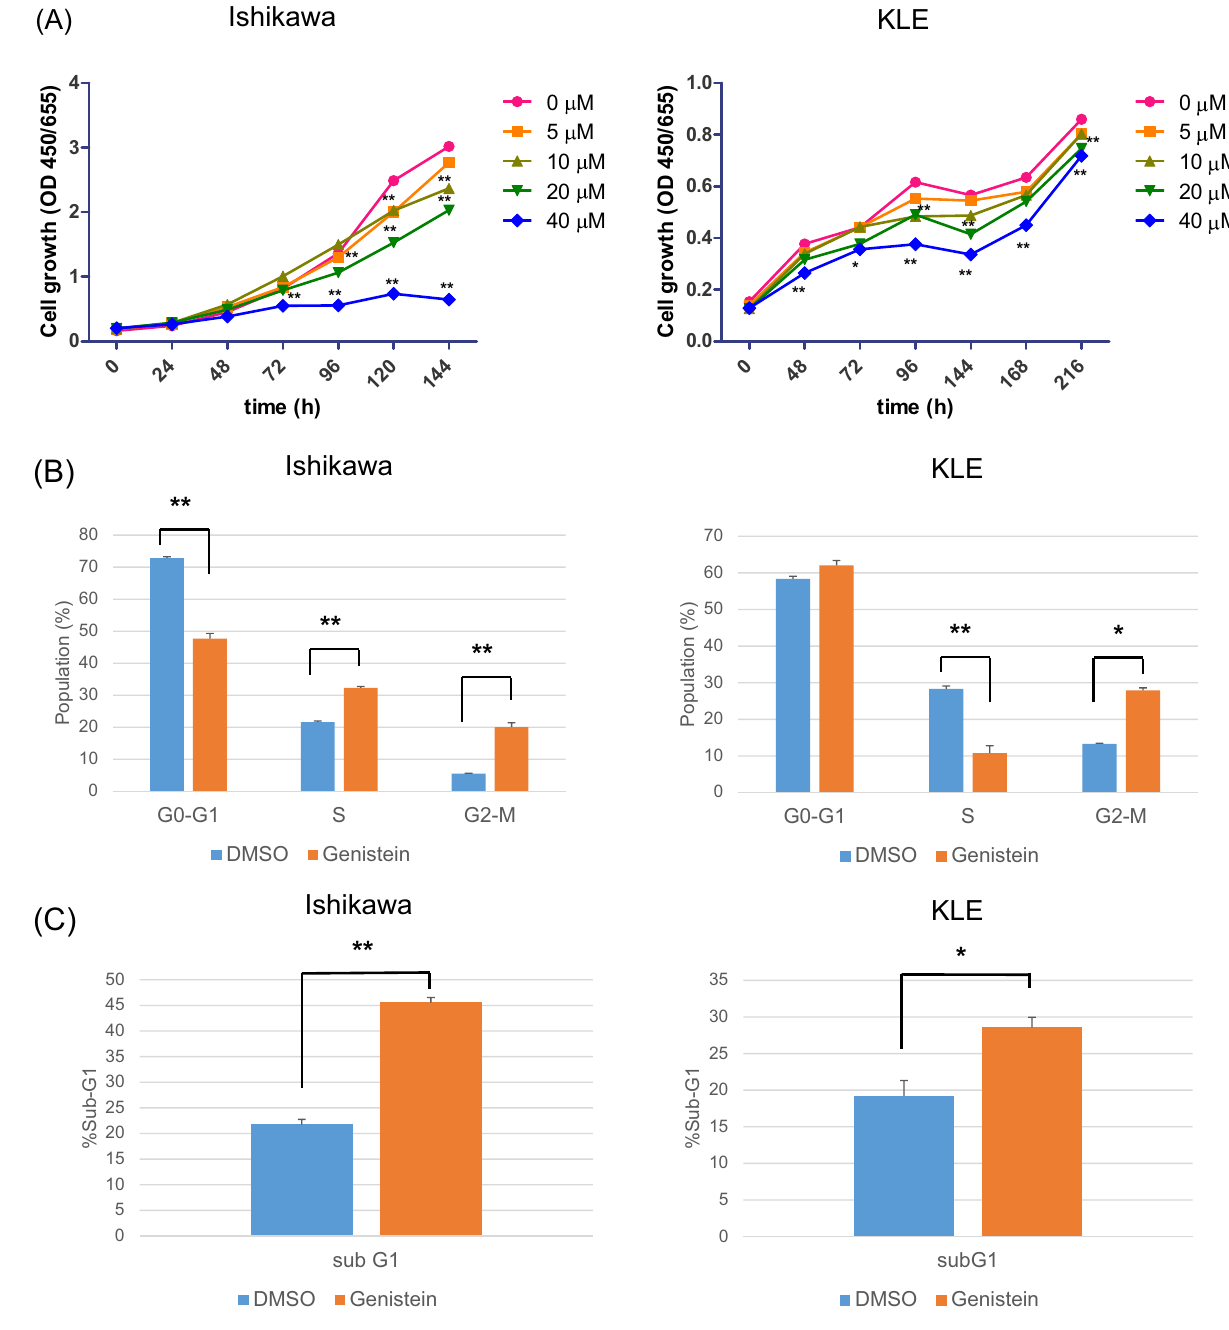
Figure 2. Effects of genistein on the proliferation of cancer cells. The water-soluble tetrazolium salt-8 (WST-8) cell proliferation assays were performed for Ishikawa and KLE cells ( A ). The viability of cancer cells was determined every 24–48 h post-treatment with 20 μM genistein. Data are represented as the mean value (n = 12). Statistical significance was determined using a two-way analysis of variance (ANOVA). Cell cycle analysis was performed using flow cytometry. Cancer cells were collected, and flow cytometry analysis was performed 144 h after exposure to genistein. Cell distribution at each phase of the cell cycle ( B ). Data represent the mean ± standard error of the mean (n = 3). Sub-G1 population of both cells ( C ). Data represent the mean ± standard error of the mean (n = 3). Western blot analysis of proteins involved in the G2/M phase (phospho-histone H3 (Ser10), cdc2, phospho-cdc2 (Tyr15), cdc25, and phosho-cdc25 (Ser216)) and apoptosis (caspase 3 and cleaved caspase 3) after 48 h of genistein treatment ( D ). Full-length western blots are presented in Supplementary Fig. 3. P values are based on Student’s t -test. * P < 0.05; ** P <